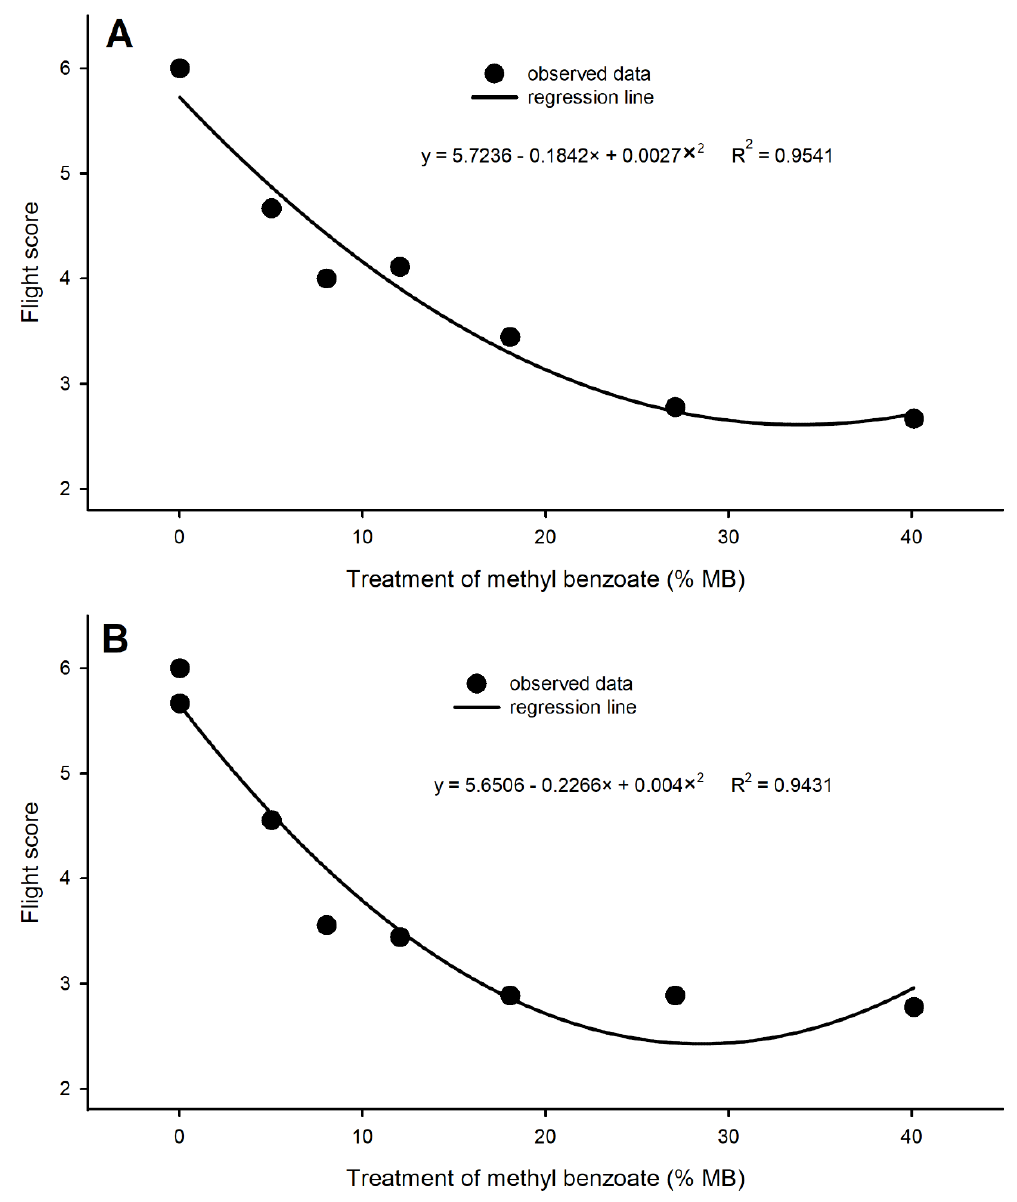
Figure 5. Regression analysis of flight score against methyl benzoate concentrations in honey bees treated with spraying ( A ) and feeding ( B ) method.